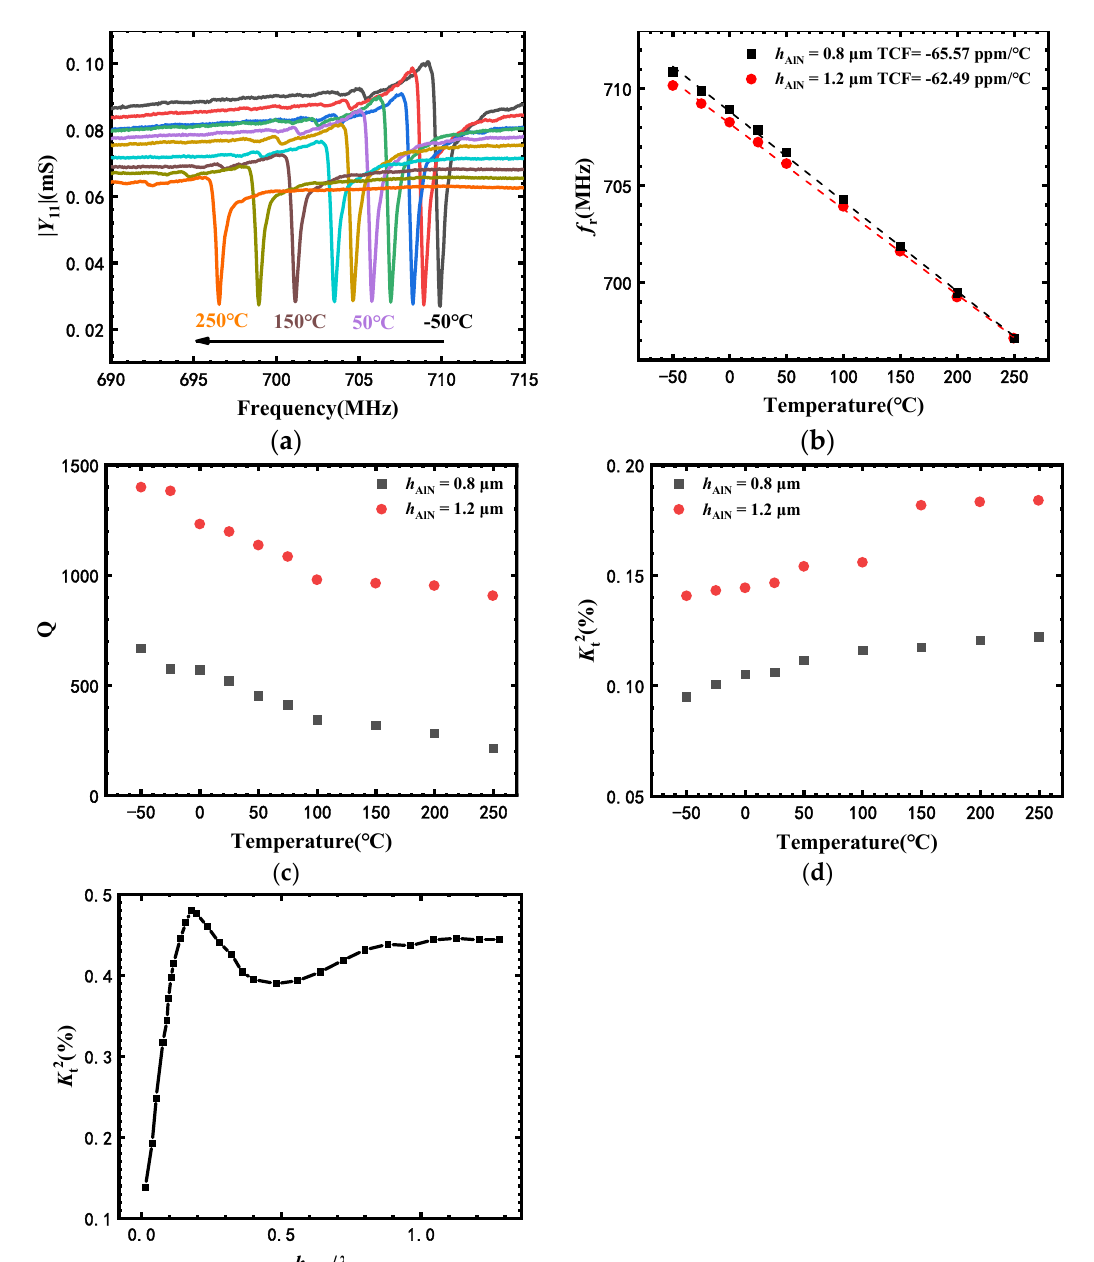
Figure 4. ( a ) Admittance magnitude | Y 11 | of SAW-B ( h AlN = 1.2 µm) versus frequency with various temperatures from − 50 °C to 250 °C. Temperature dependency of ( b ) f r , ( c ) Q, and ( d ) K t2 of sensors with different AlN film thicknesses; ( e ) dependence of K t2 of sensors on h AlN / λ ( λ = 8 µm) by FEM simulation.